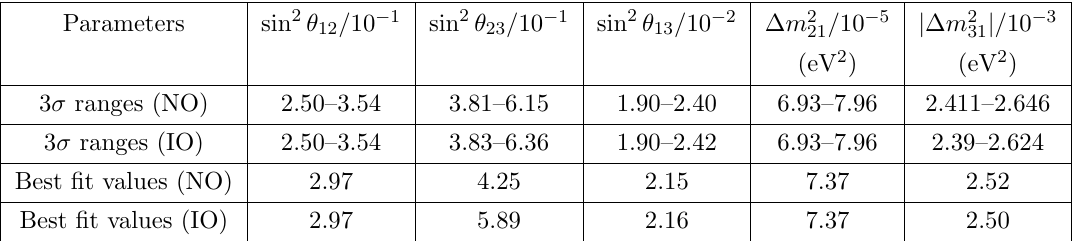
Table 2 . Input values fed into the analysis